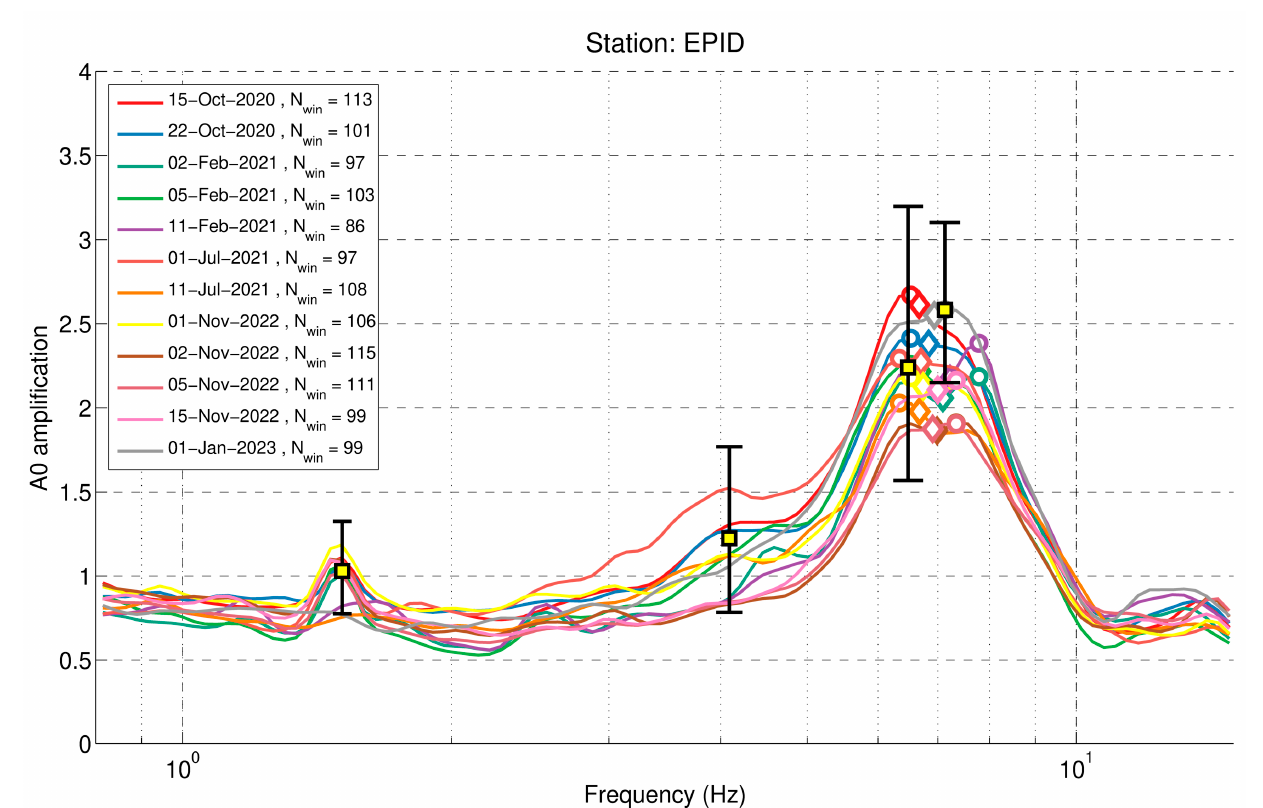
Figure 18. Location of the seismological station EPID and the geophysical measurements along with the geology of the area.